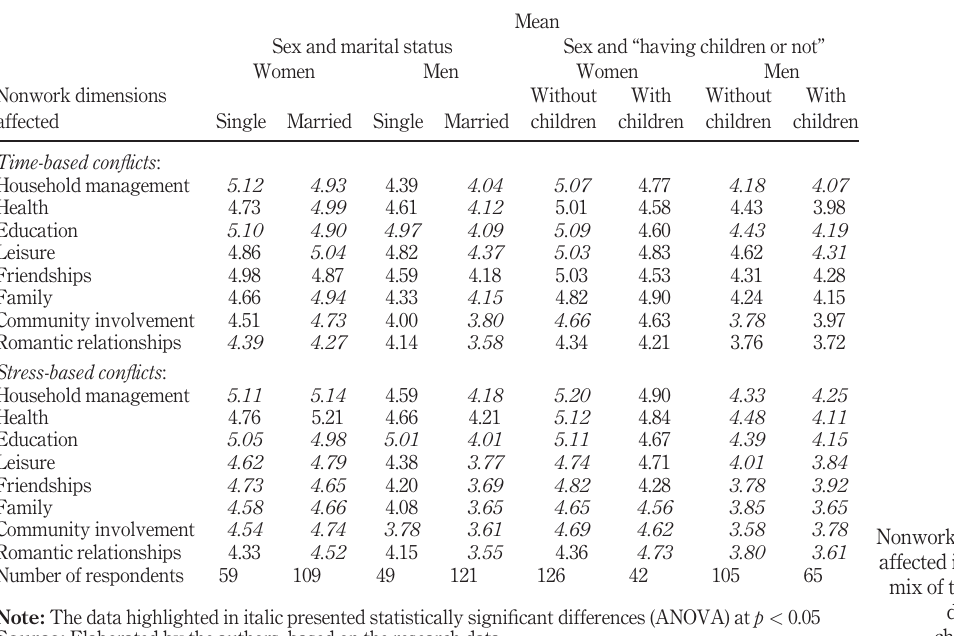
Table 5. Nonwork